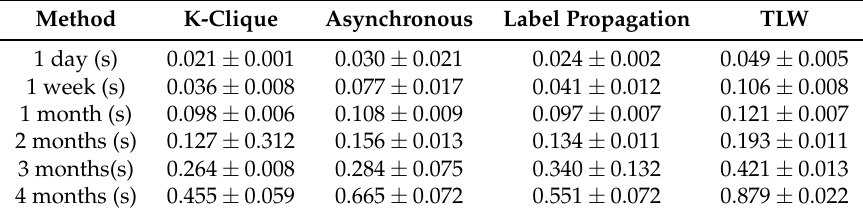
Table 3. The running time with the increase of ∆ t about different methods.